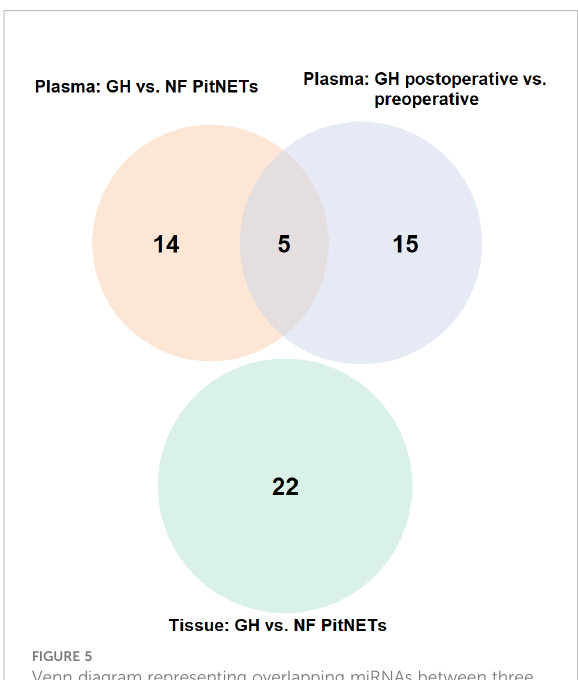
FIGURE 5 Venn diagram representing overlapping miRNAs between three differential expression analyses: (1) plasma of GH secreting PitNETs vs. NF PitNETs, (2) plasma of GH secreting PitNETs 24